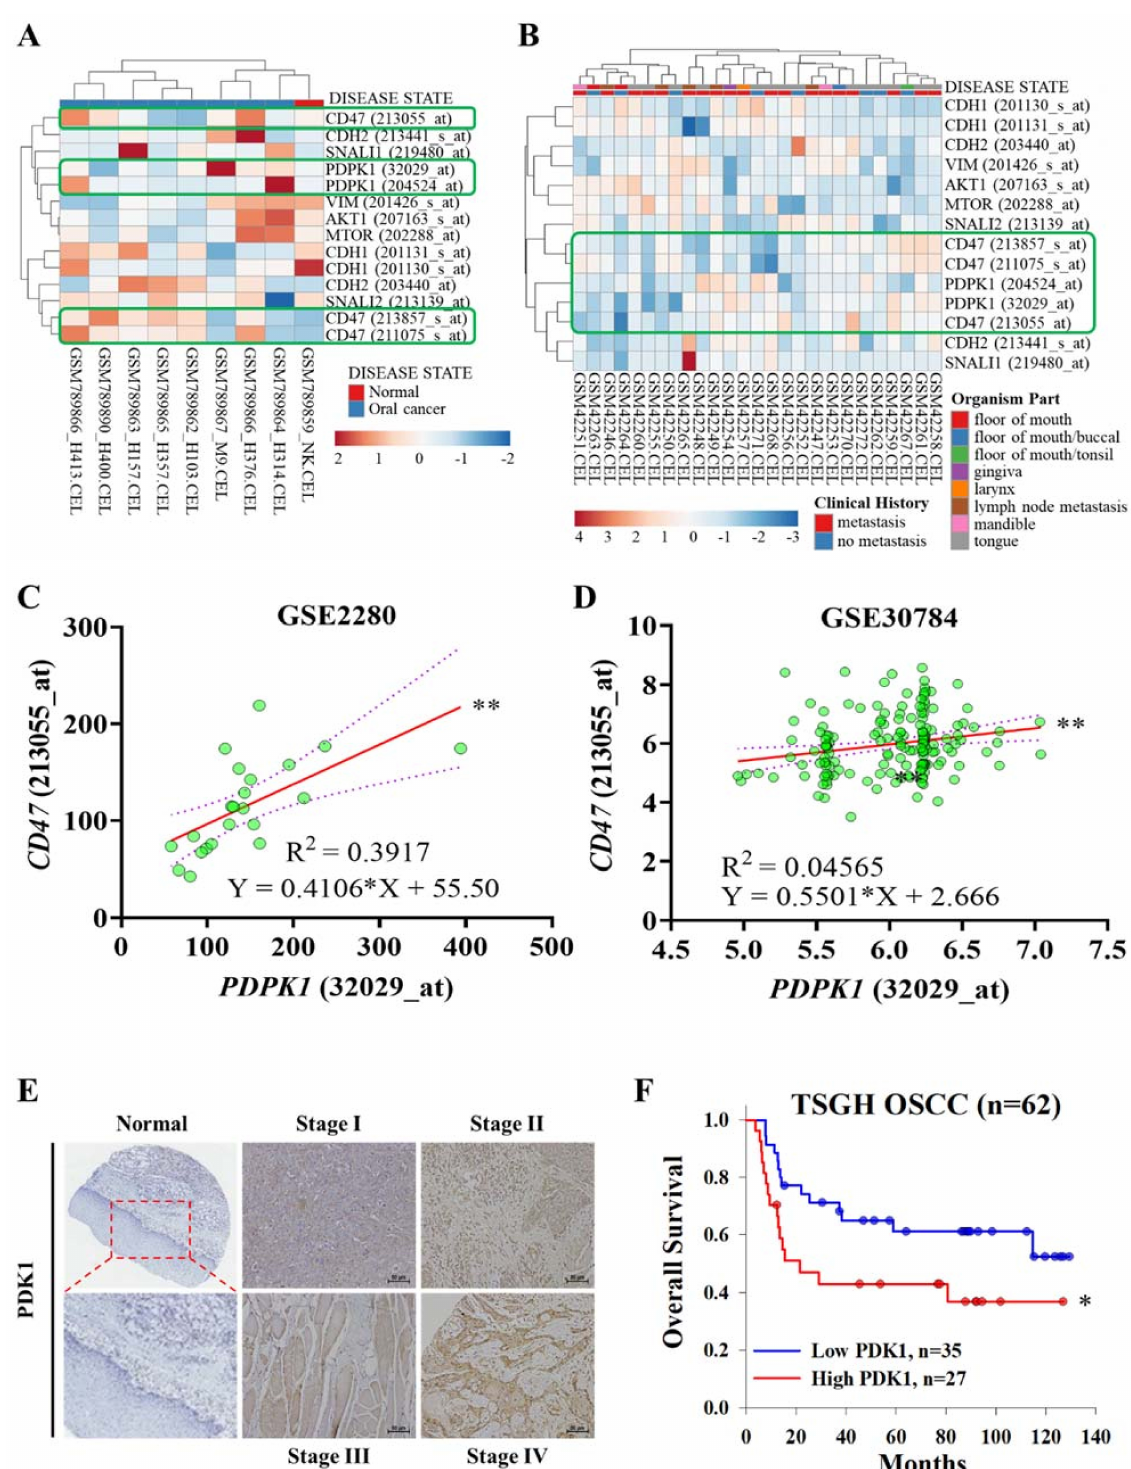
Figure 1. PDK1 confers a poor prognosis in OSCC. ( A , B ) Heatmap of GSE2280 and GSE30784 gene expression profiling. ( C ) Graphical representation of PDPK1 and CD47 mRNA coexpression analysis in GSE2280 with R 2 = 0.4237, p < 0.001 and ( D ) in GSE30784 with R 2 = 0.04565, p < 0.01. ( E ) Immunohistochemical staining of PDK1 in TSGH OSCC tissue categorized based on stages. ( F ) PDK1 expression for predicting patients with overall survival in TSGH OSCC ( n = 62). The 5-year OS was 61.0% and 42.9% in BTK-low ( n = 35) and BTK-high ( n = 27) OSCC patients, respectively ( p < 0.05). Q-score < 140 indicated BTK-low and Q-score ≥ 140 indicated BTK-high. * p < 0.05 and ** p < 0.001; scale bar 50 µ